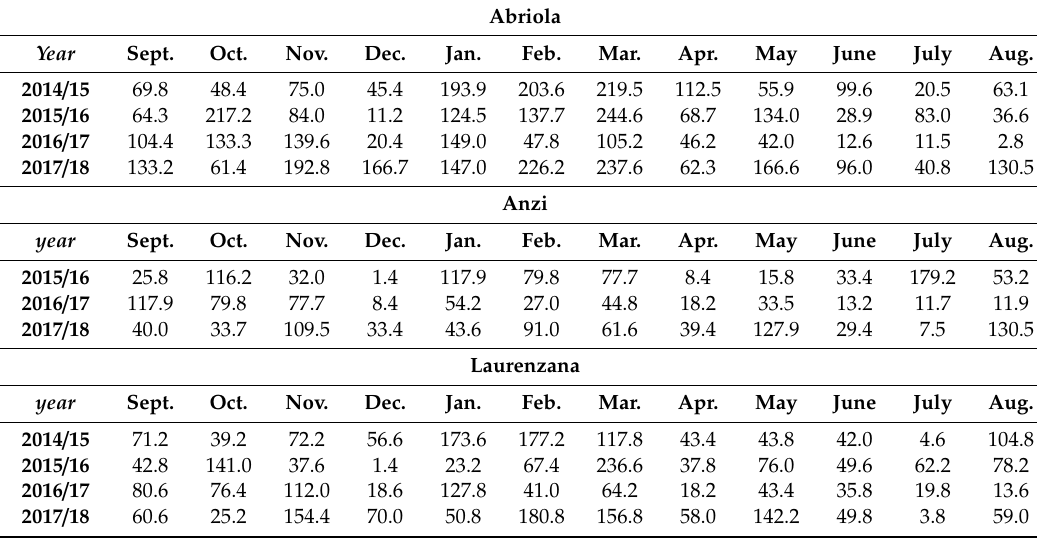
Table 2. Pluviographic data